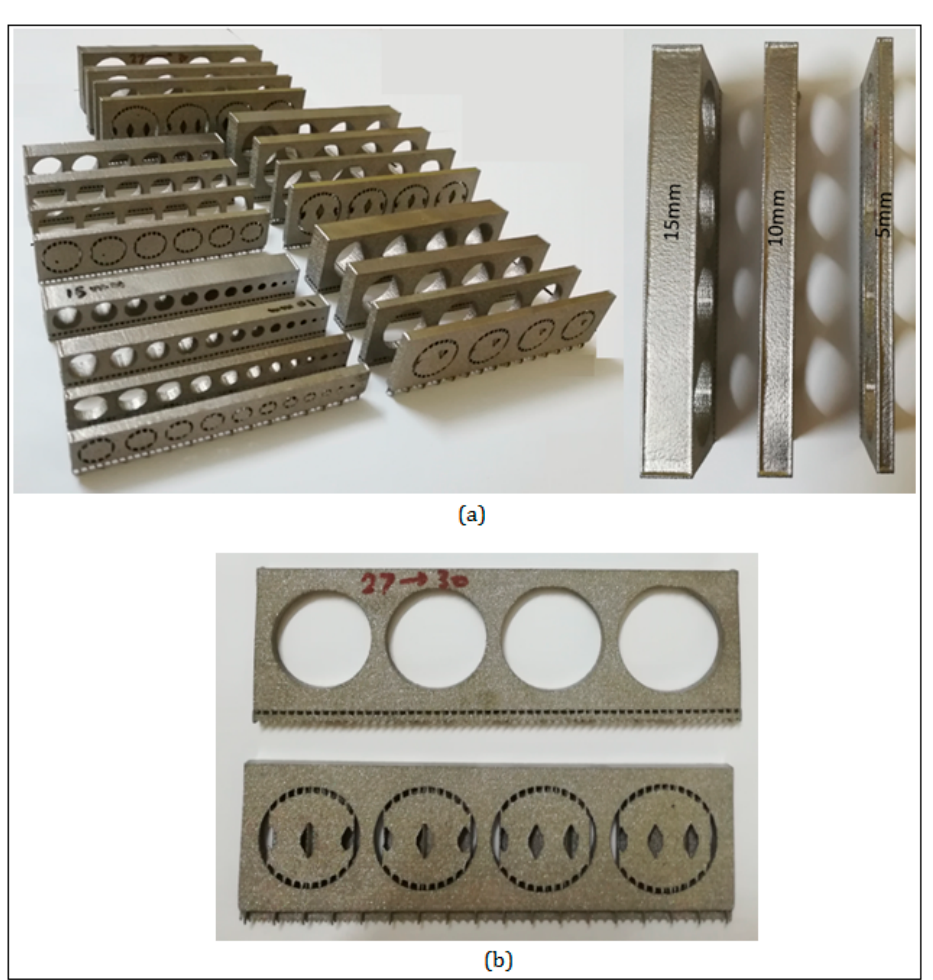
Figure 11. ( a ) All fabricated test specimens; ( b ) Test specimens without and with support structures.